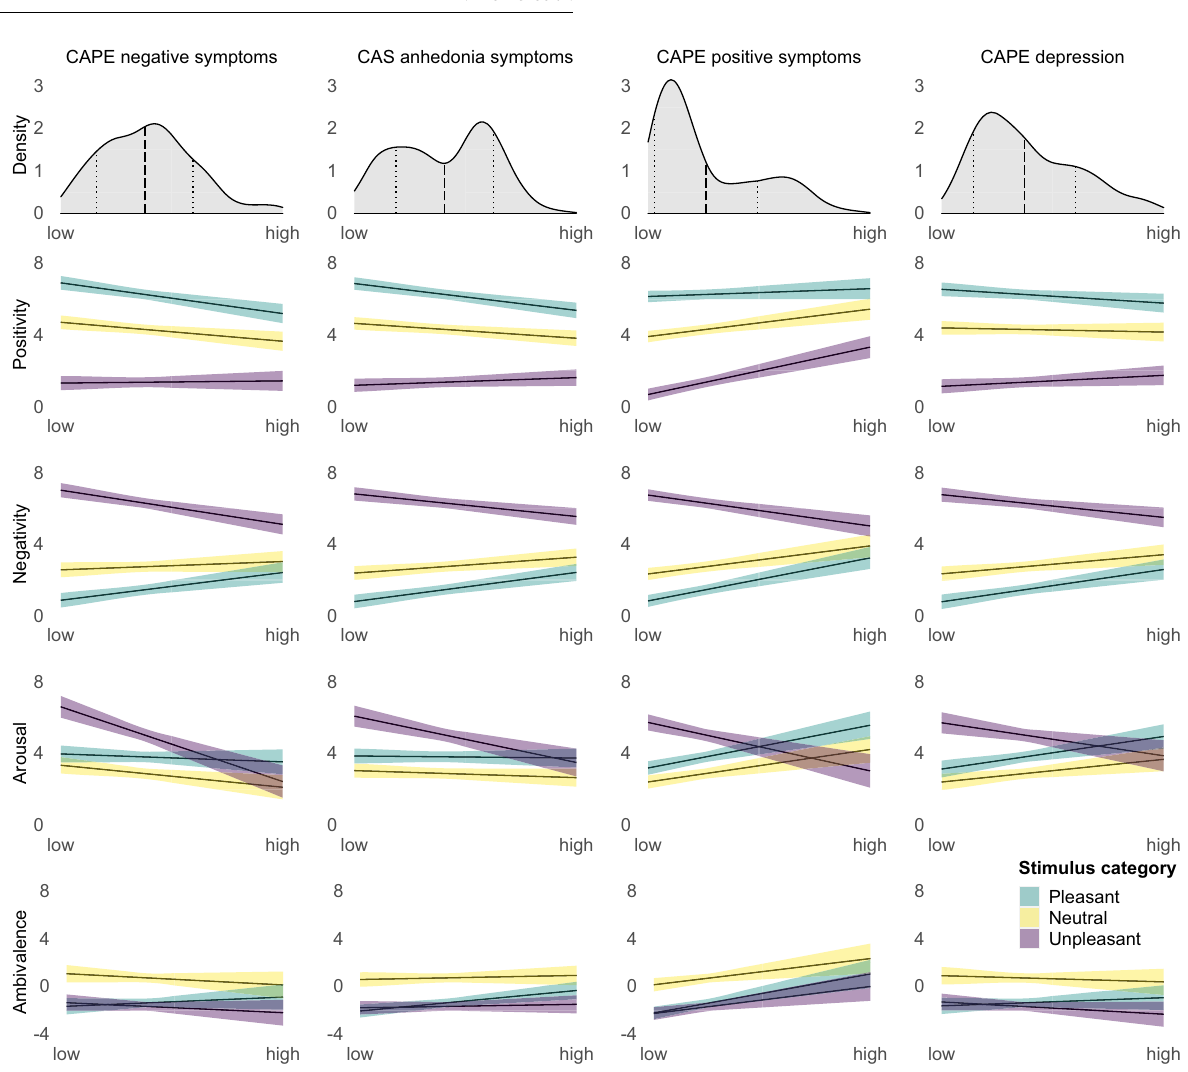
Fig. 2 Sample distribution of symptom scale scores and moderator effects of each symptom scale on positivity, negativity, arousal, and ambivalence for each picture category based on the MLM. The top row shows the sample distribution of the scores for each symptom scale (density function estimated with 1/30 observations, thus 8 – 9 participants per data point). The dashed lines represent the mean, the dotted lines ±1 SD. In the 4 (response scale) by 4 (symptom measure) line plots, each line corresponds to the effect of a given moderator within a given stimulus category. The shaded error bars illustrate the 95% CI. The “ low ” and “ high ” endpoints of the x -axis correspond to the observed minimum and maximum values for the respective symptom measure (cf. Table